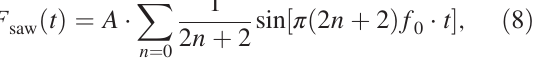
Figure 3 visualizes the two modulation types for different values of N .